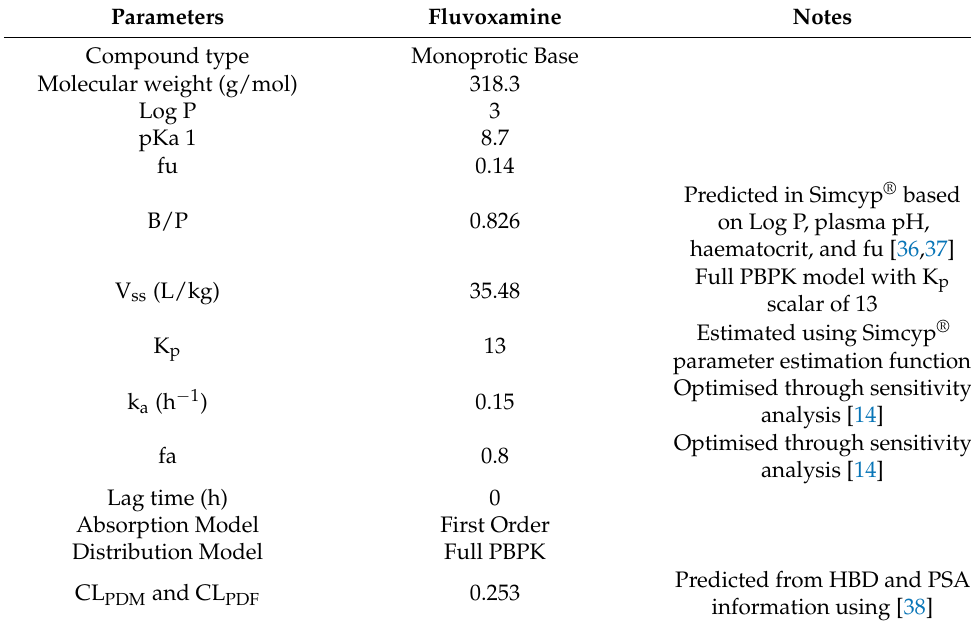
Table 1. Fluvoxamine compound parameters determined through a full PBPK model.